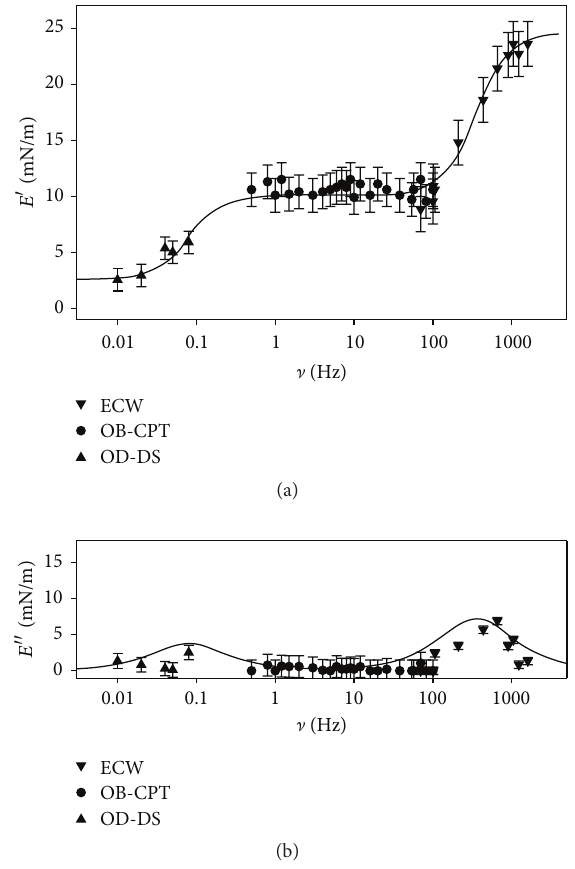
Figure 5: For dispersion with 1wt% of silica nanoparticles and CTAB in concentration of 0.5 mM: (a) Real part of the viscoelastic modulus. (b) Imaginary part of the viscoelastic modulus. The solids lines correspond to the best fitting to the model proposed by Ravera et al. [34]. Reproduced from [37] with permission from The Royal Society of